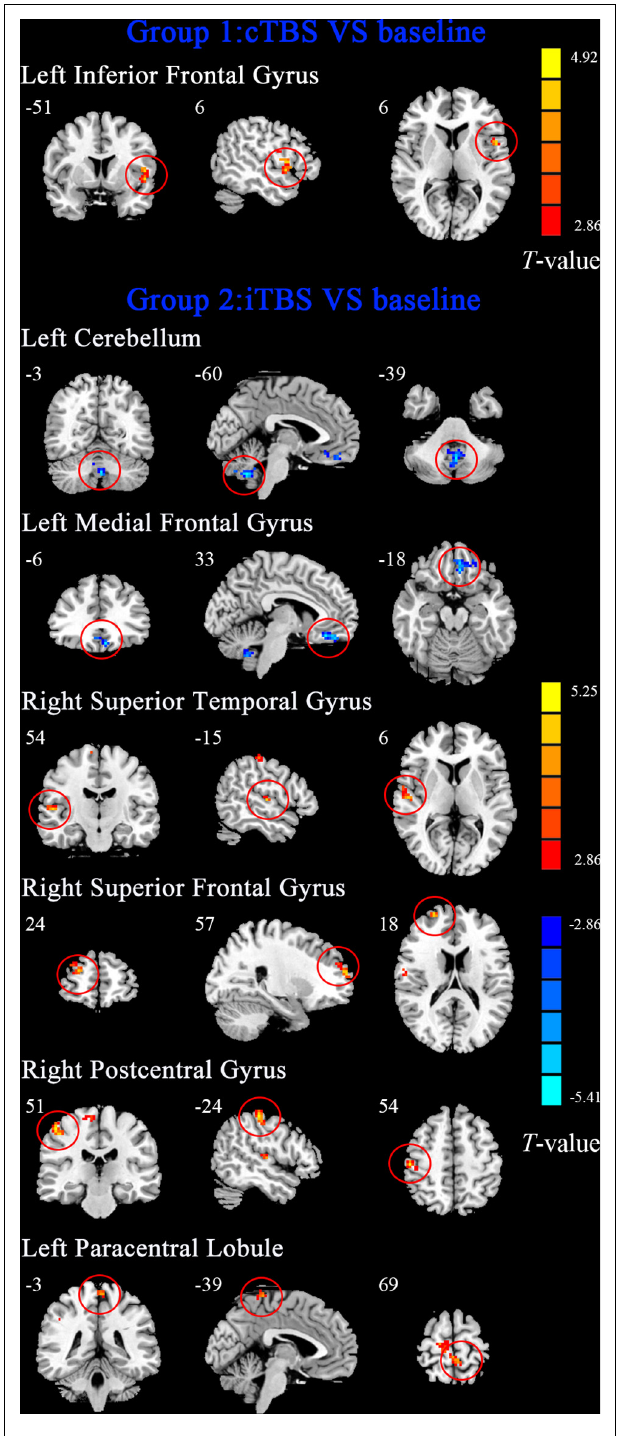
FIGURE 1 | The maps showed that the alteration of degree centrality (DC) after continuous theta-burst stimulation (cTBS) and intermittent theta-burst stimulation (iTBS) protocols on the motor cortex of suprahyoid motor cortex in healthy subjects. Regions with red color represent significantly increased DC values in the theta-burst stimulation (TBS) compared with the baseline, and blue indicates the opposite ( p < 0.01, corrected). The details are described in Table 2 . The color bar indicates the t